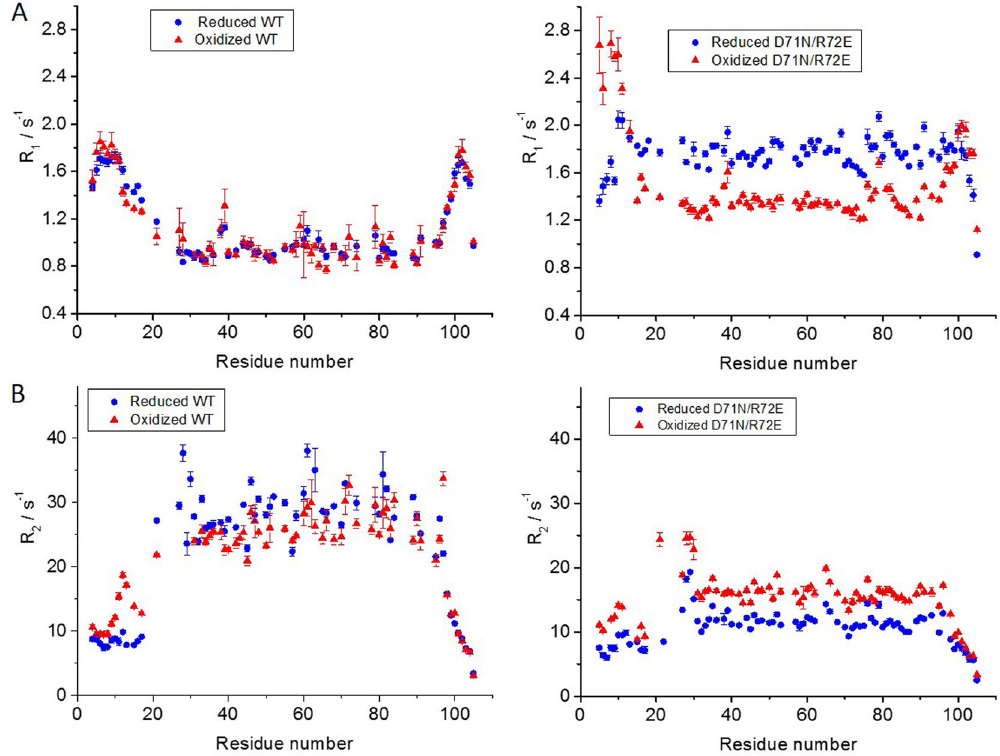
Figure 4. Relaxation rates of backbone 15 N measured for BIR1 at 298 K in different conditions. ( A ) R 1 of WT BIR1 and D71N/R72E mutant in the oxidized and reduced states. ( B ) R 2 of WT BIR1 and D71N/R72E mutant. The protein concentration was about 0.3 mM in 20 mM Bis-Tris buffer at pH 6.5.